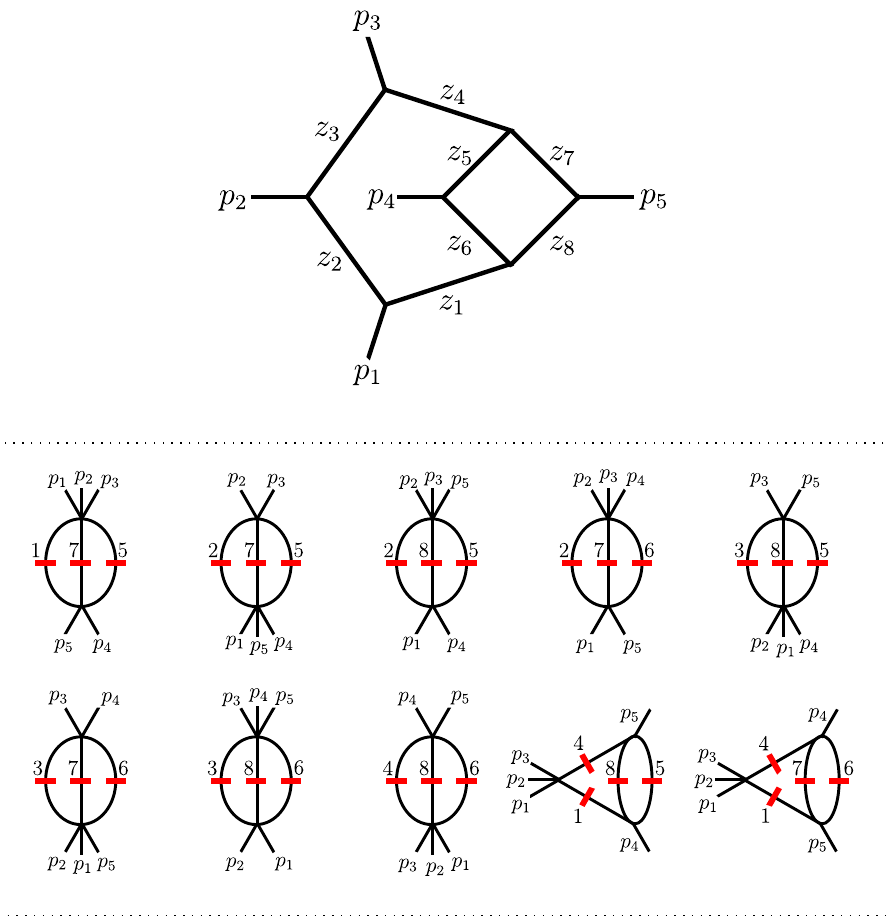
Figure 1 . The fully massless non-planar hexagon-box diagram, along with our labelling conventions for its internal lines. The lower part shows the subset of the basis integrals with the property that their graphs cannot be obtained by adding internal lines to the graph of another basis